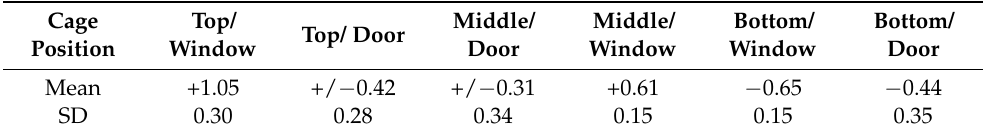
Table 2. Average differences in room temperature depending on the arrangement of cages ( ◦ C) in relation to the general room